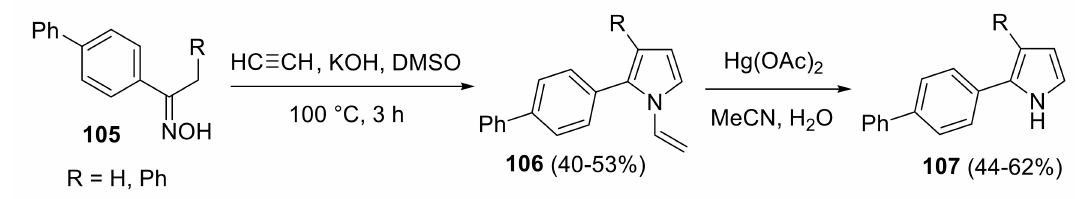
Scheme 57. Trofimov heterocyclization of bifenyl-derived